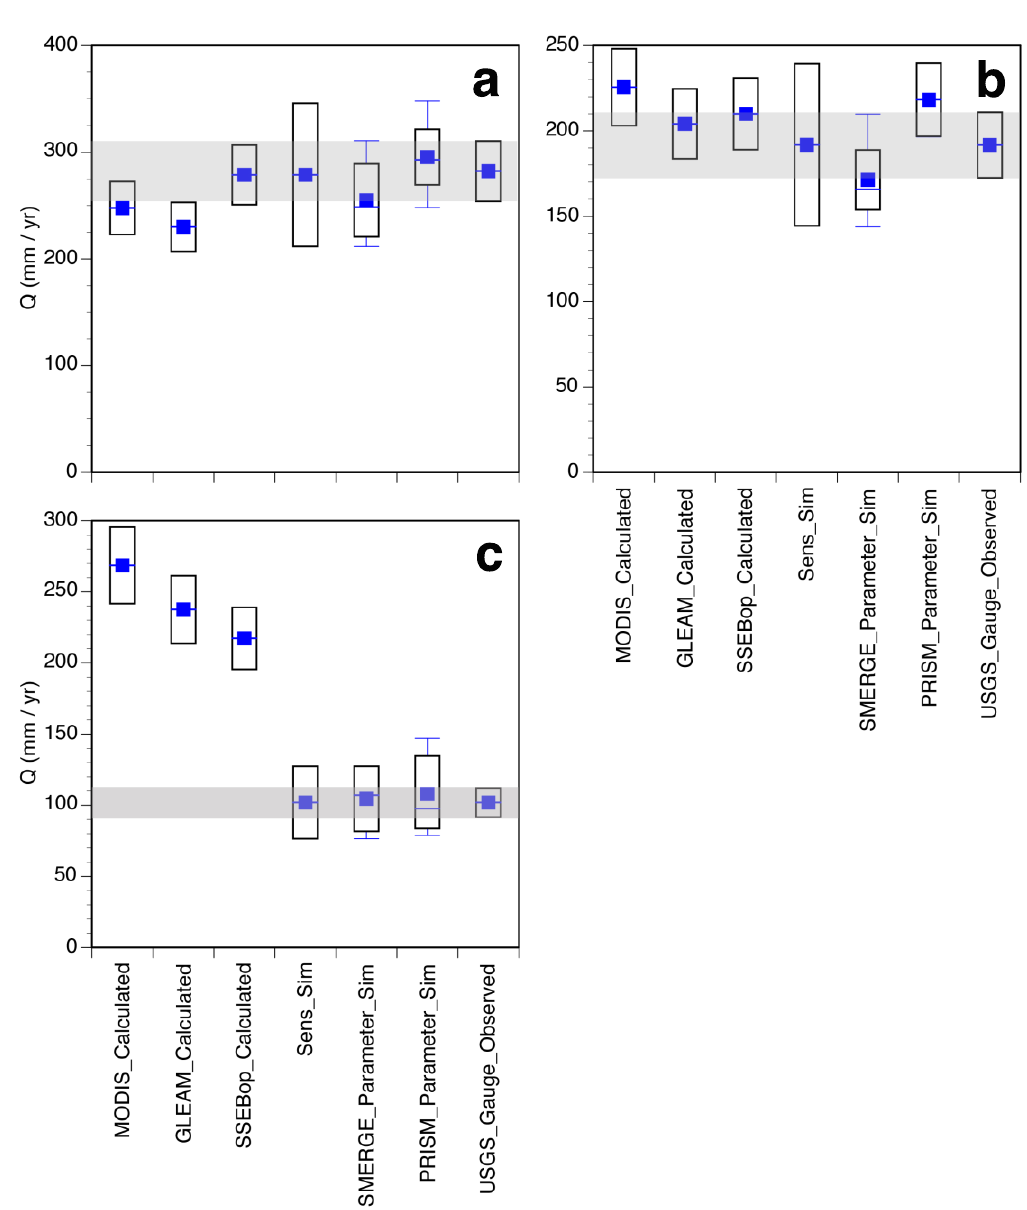
Figure 9. Same as Figure 5. ( a ) MC-2016, ( b ) MC-2017, and ( c ) MC-2018.